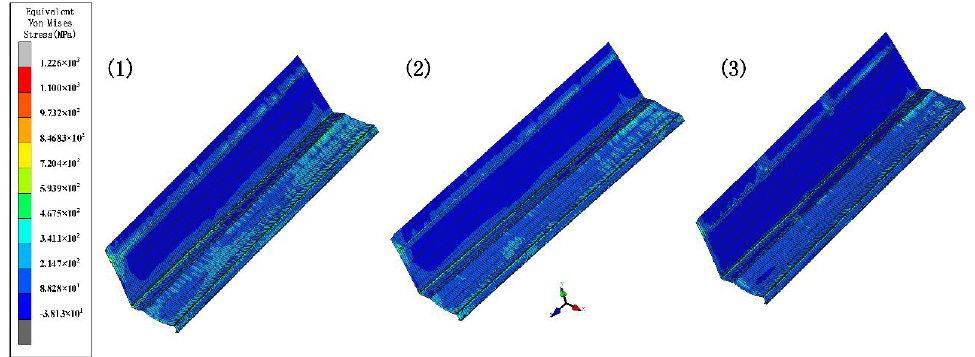
Figure 16. The variation in the equivalent von Mises stress distribution of strip under different diameter increments.